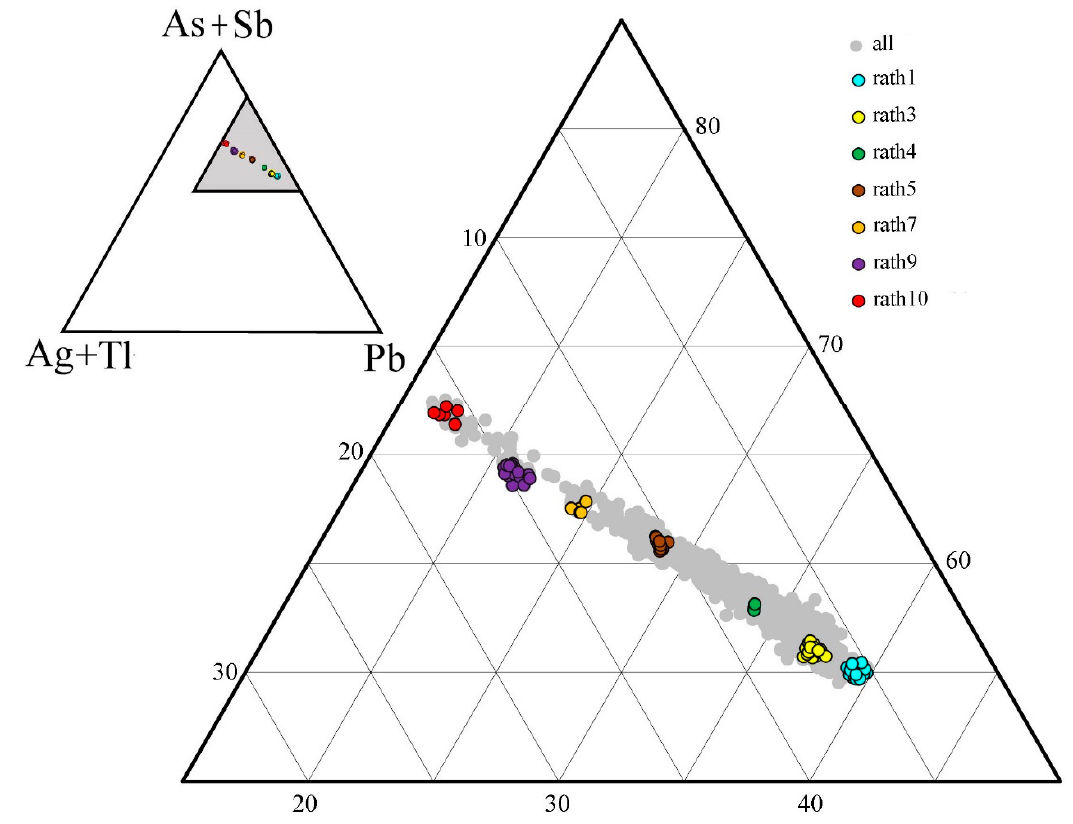
Figure 4. Substitutional variations in rathite from Lengenbach in the (As + Sb) − (Ag + Tl) − (Pb) sulphide ternary plot (at %). The grey dots show all 2700 spot analyses, while samples rath1 to rath9 are those also characterized by crystal-structure refinements. Most of the analyses belong to the rath3–rath5 interval (1.58 wt%–5.36 wt% Tl). Low-Tl (rath1, typical of Reckibach samples) and